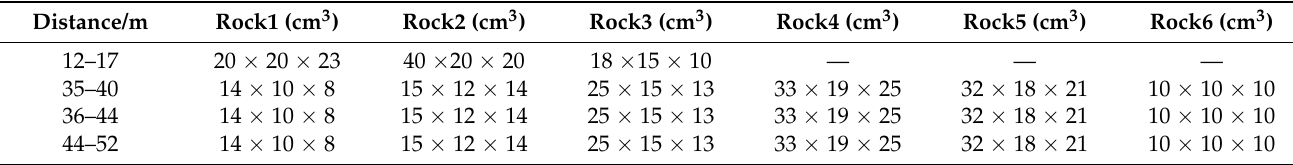
Figure 7. The place where the data was collected in the experiment. ( a ) Vehicles used in the experi- ment; ( b ) randomly placed rocks on the road; ( c ) side of the vehicle; ( d ) the detail of the equipment. Table 1. Rock size and placement